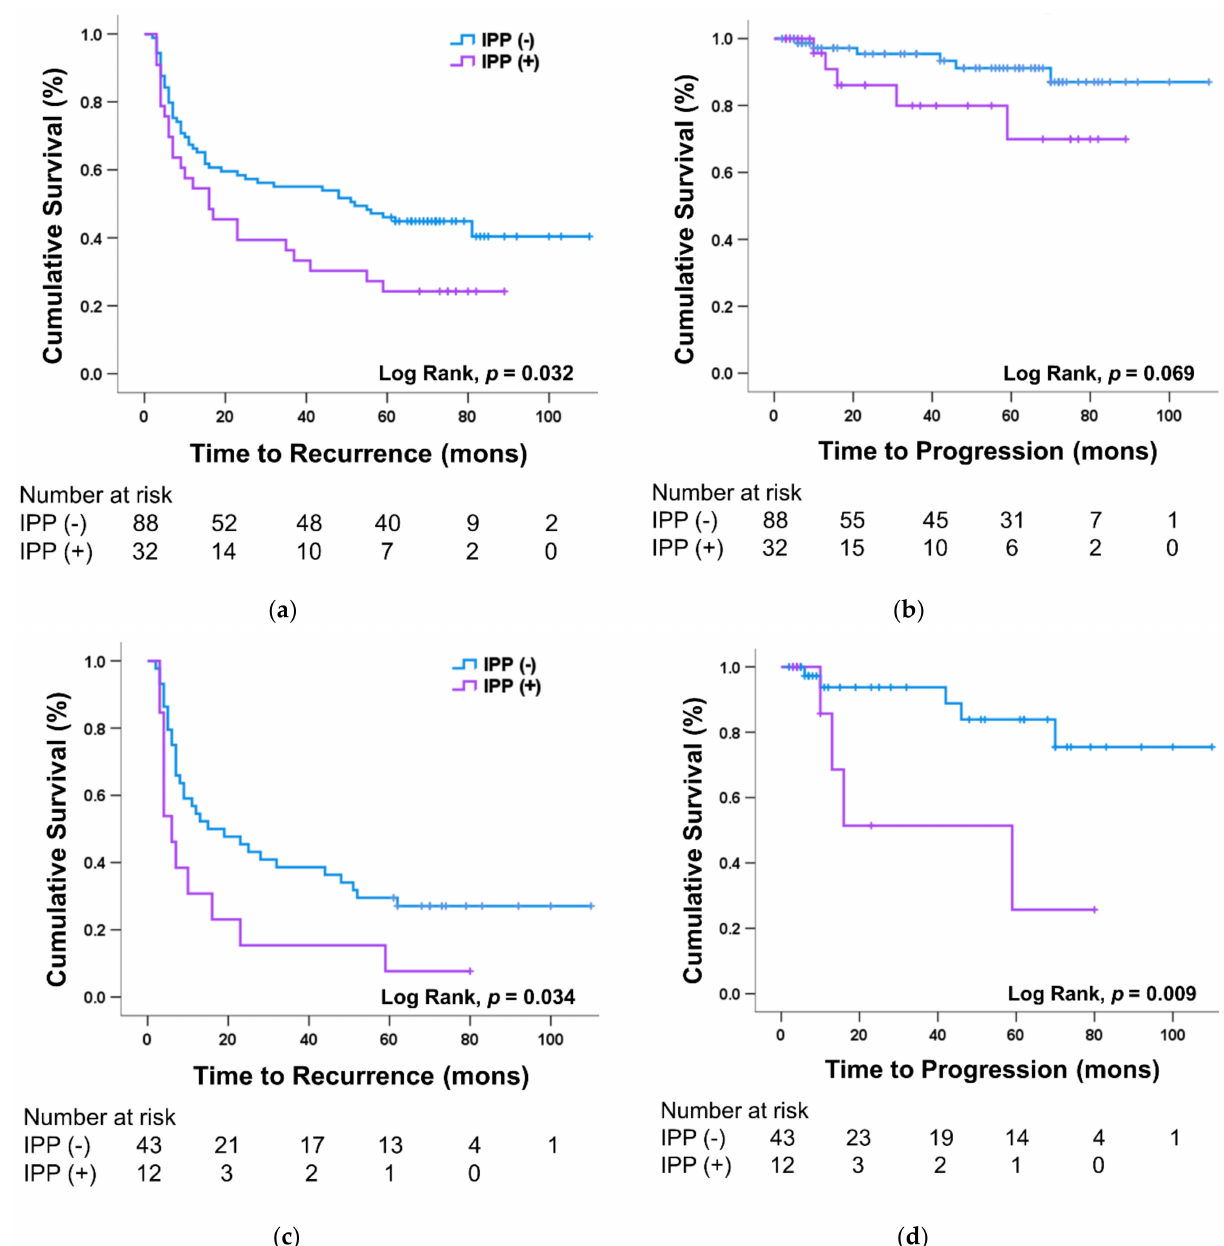
Figure 2. Kaplan − Meier plot for ( a ) recurrence and ( b ) progression comparing patients with or without severe-grade (grade 2–3) intravesical prostatic protruding (IPP). The difference in ( c ) recurrence and ( d ) progression with or without severe IPP in patients with high-risk non-muscle invasive bladder